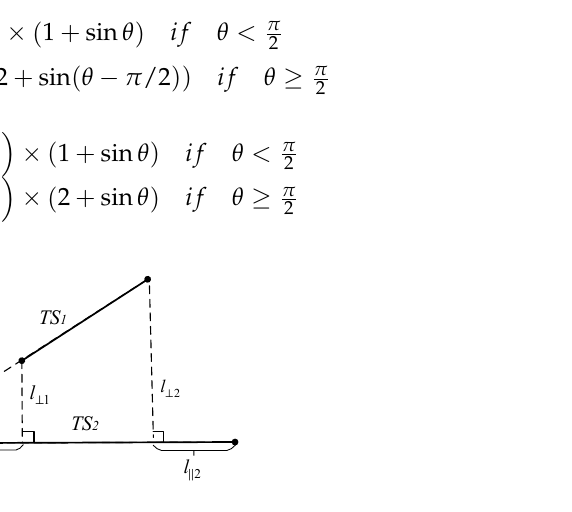
Figure 3. The illustration of distance measure between the two trajectory segments.